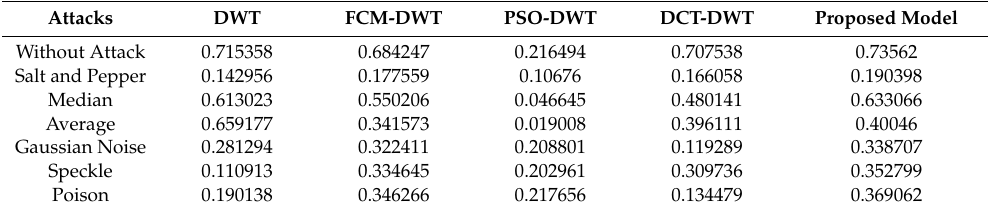
Table 3. Cross-correlation (CC) values of di ff erent models and the proposed model after extracting the watermark.